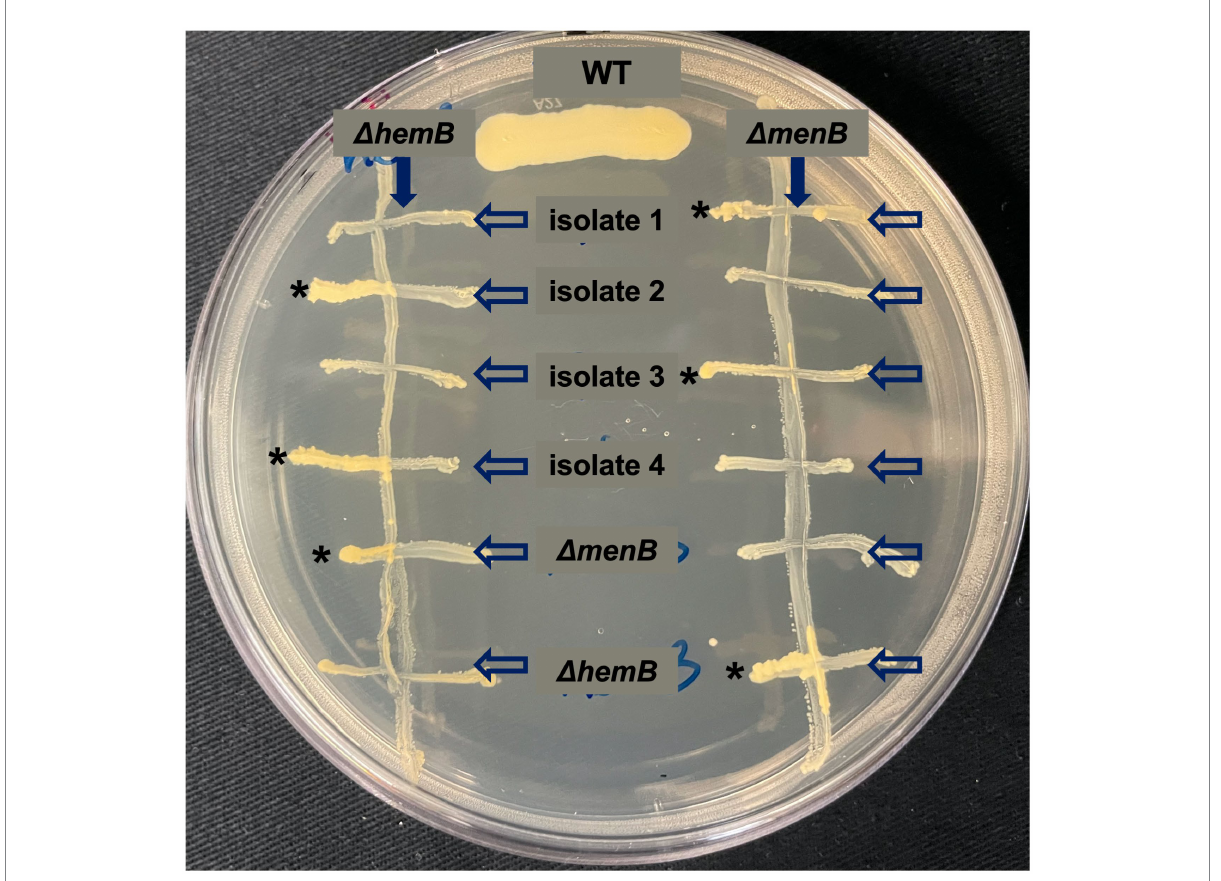
FIGURE 5 Cross-streaking experiments uncover apparent auxotrophies for stable, iron starvation-induced SCV isolates. Representative plate of cross- streaking experiment in which a menaquinone-deficient Δ menB or a heme-deficient Δ hemB were streaked vertically downward as a primary streak (direction of primary streak is emphasized by a solid arrow). SCV isolates and Δ menB and Δ hemB as controls were cross-streaked horizontally (direction of the secondary streak is emphasized by unfilled arrows). When a heme-deficient and menaquinone-deficient strain intersect, a moderate growth rescue resembling the WT control streak can be observed (marked with *). In this way, apparent auxotrophies could be assigned for most SCVs that evolved during prolonged exposure during iron starvation. The raw photograph of this plate can be viewed in Supplementary Figure